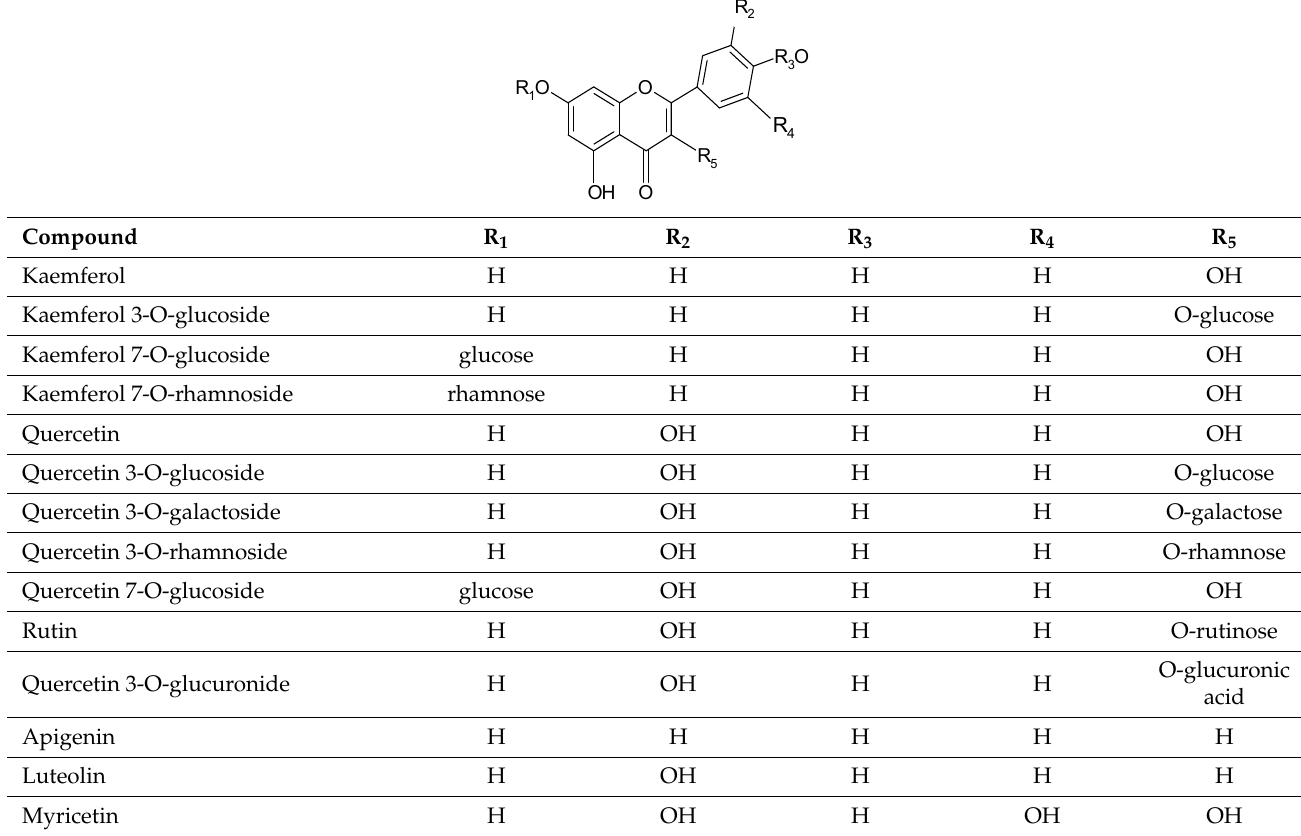
Table 1. Structural formulas of selected flavonoid aglycons and glycosides.